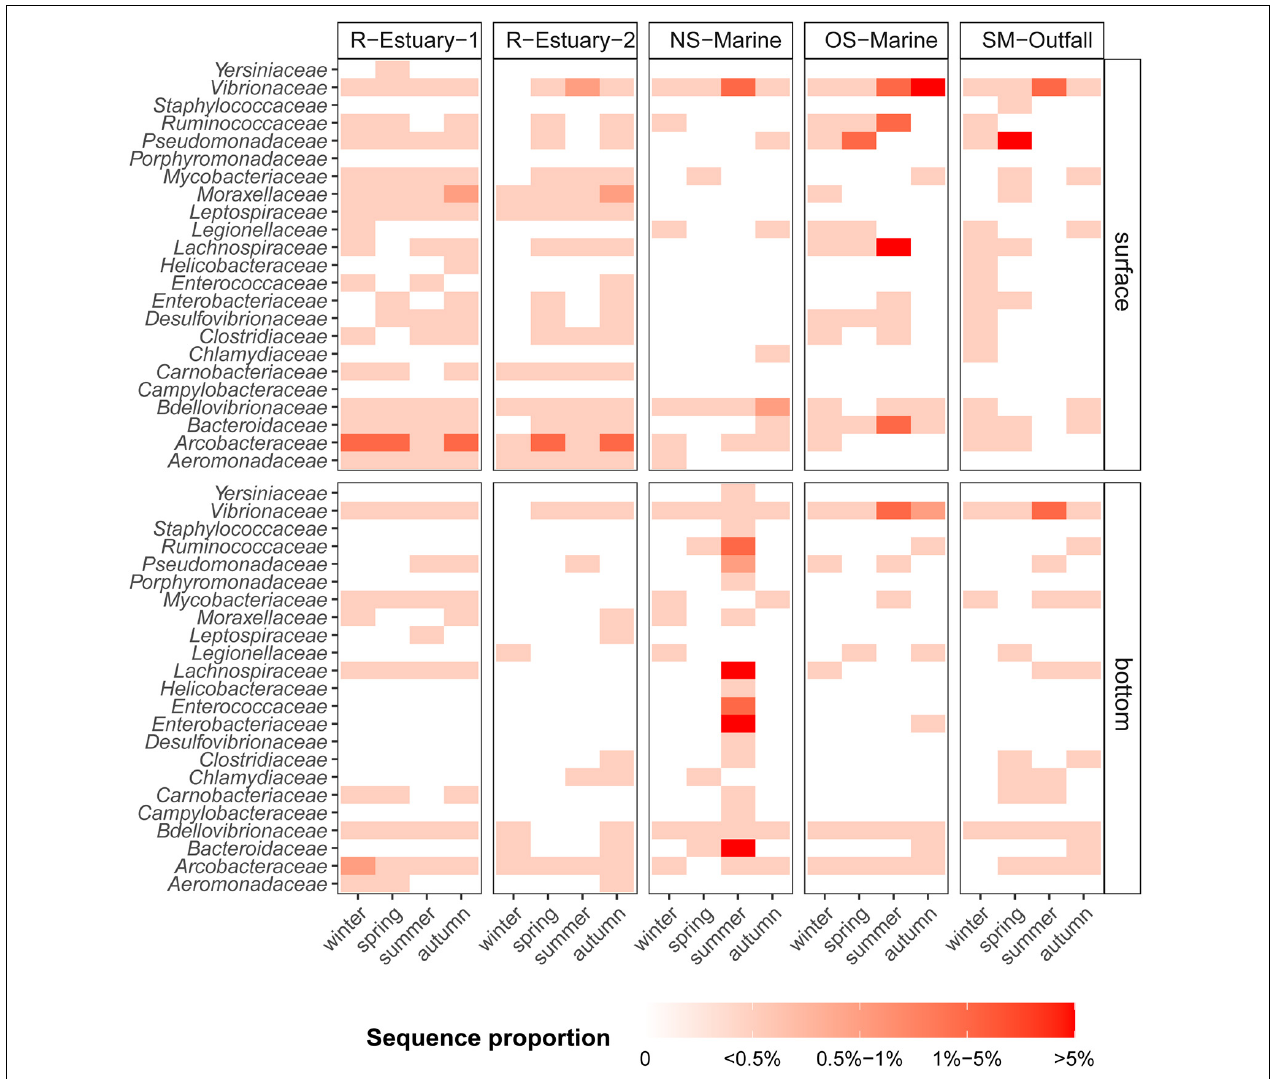
FIGURE 6 | Sequence proportion heatmap (white = absent, red = high) of selected family-level bacterial indicators at five sampling stations (R-Estuary-1, R-Estuary-2, NS-Marine, OS-Marine and SM-Outfall) in winter, spring, summer, and autumn sampling during the 2018/2019 survey.